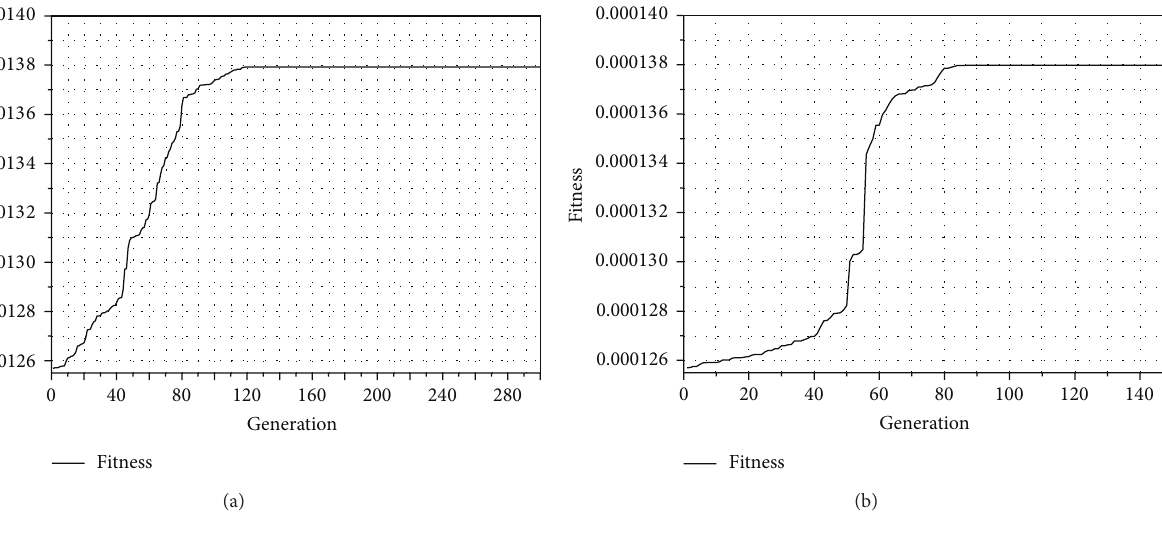
Figure 5: Evolutionary curve of E2 (left) and E3 (right).